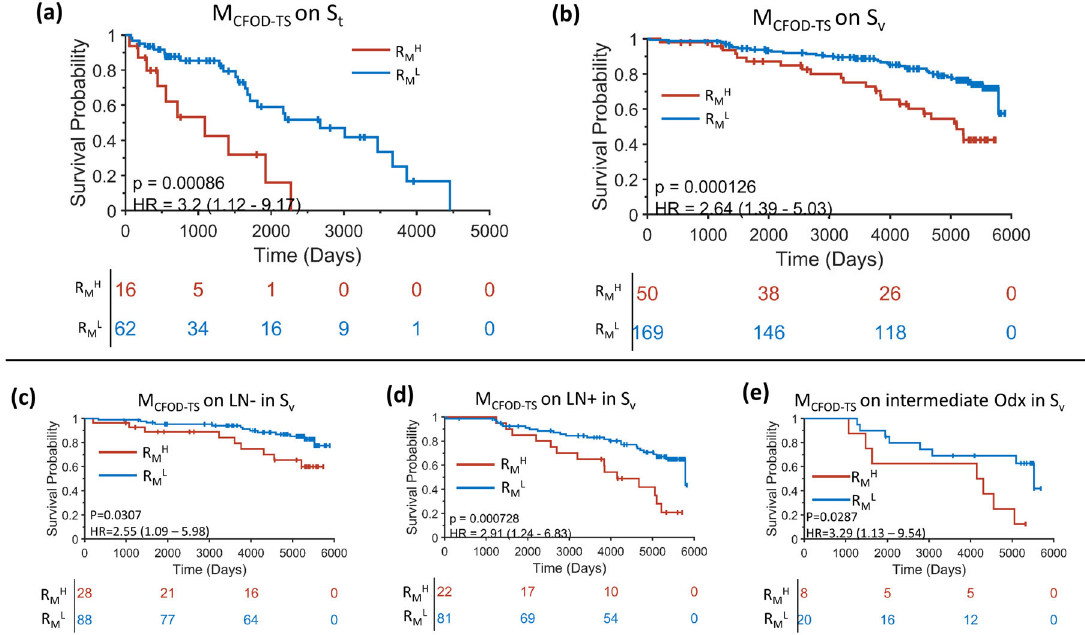
Fig. 3 Prognostic performance of M CFOD-TS on S t and S v . KM curve estimates of DFS on R ML versus R MH on S t ( a ), S v ( b ) and subgroups in S v ( c – e ) including subgroup of lymph node negative ( c ), lymph node positive ( d ) and intermediate Odx risk category ( e ) patients. The number of patients at risk at each time point is speci fi ed below the KM